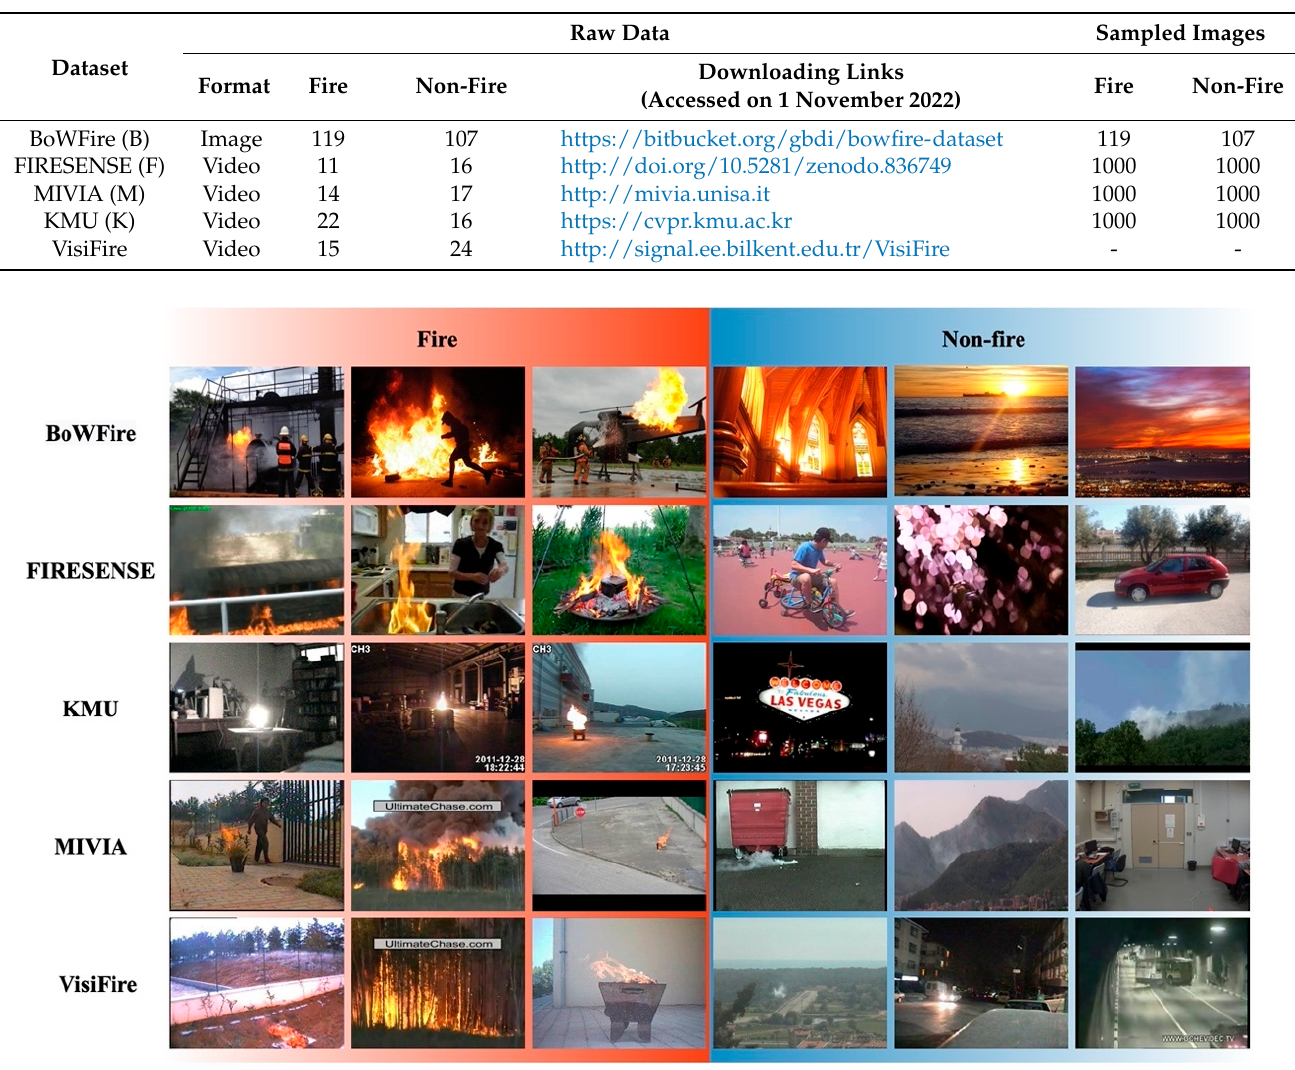
Table 1. The detailed statistics of the Fire-DA.